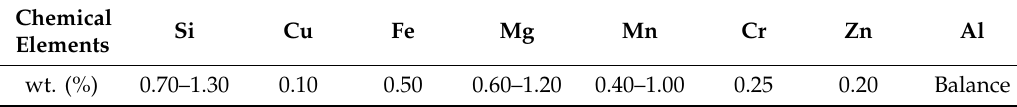
Table 2. Nominal chemical composition of Al6082-T4 (wt.%).